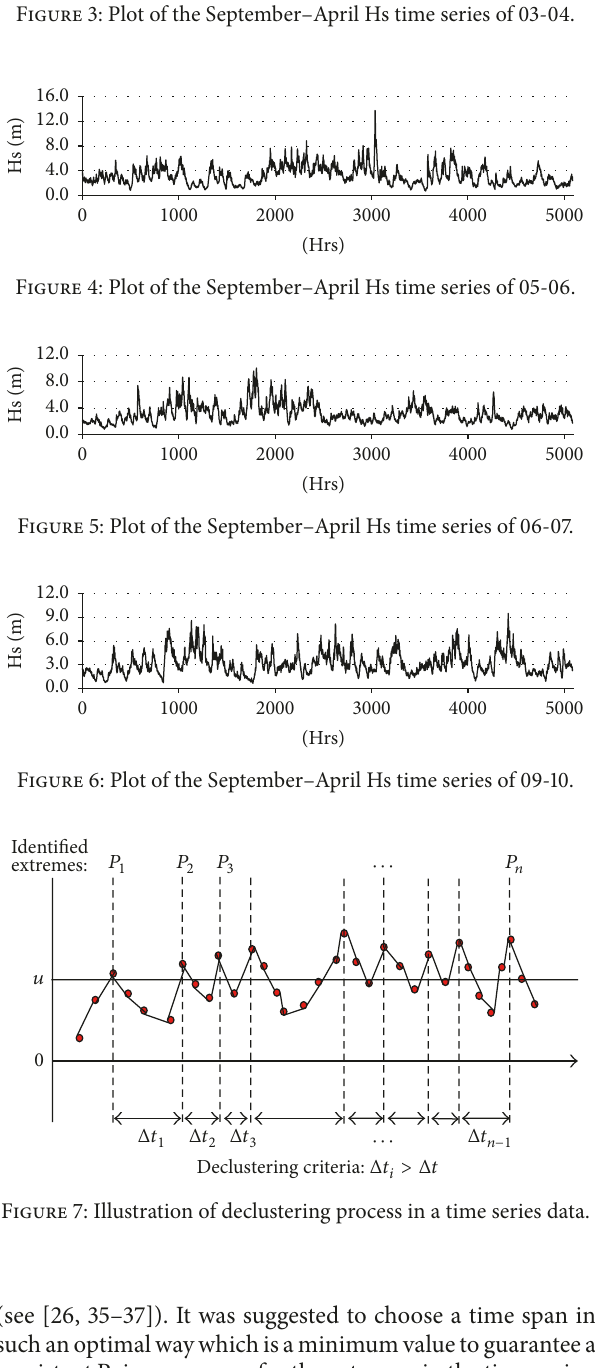
(see [26, 35–37]). It was suggested to choose a time span in such an optimal way which is a minimum value to guarantee a persistent Poisson process for the extremes in the time